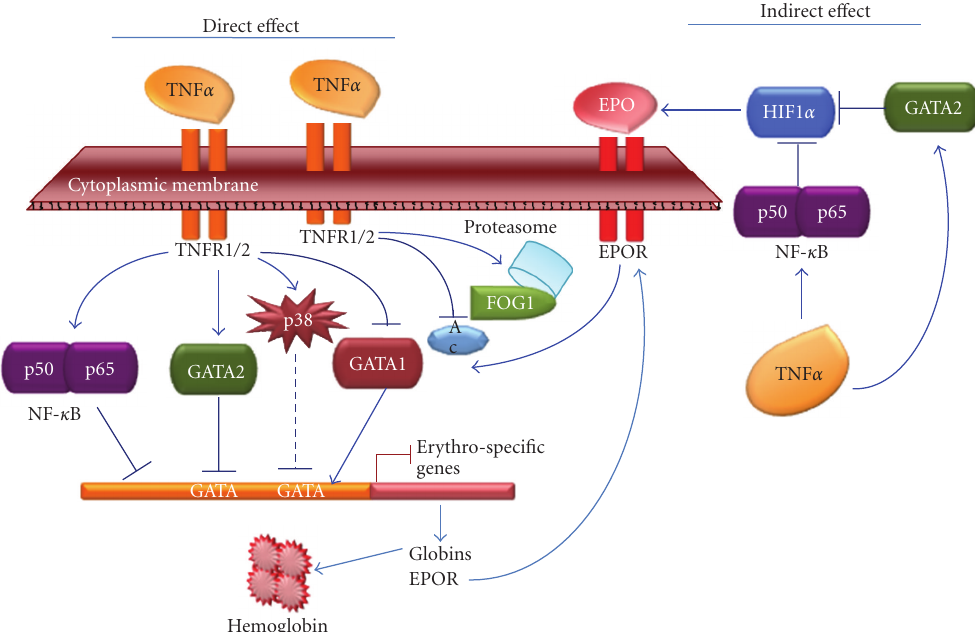
Figure 1: TNF α inhibits erythropoiesis by direct and indirect e ff ects . In the indirect e ff ect, TNF α activates the transcription factors NF- κ B and GATA-2, which were also reported as involved in Epo production inhibition by blocking HIF1 α in vitro. Low level of Epo decreases the EpoR-mediated signaling pathways resulting among others, in the down-regulation of GATA-1, and consequently in a possible deregulation of EpoR expression. The direct e ff ect of TNF α via its receptors TNFR1/2 has also been demonstrated. The activation of the NF- κ B canonical pathway (p50/p65) inhibits erythro-specific genes expression as globin genes. TNF α was also reported as activating GATA-2 whose over- expression is known to prohibit erythropoiesis in favor of megakaryopoiesis. Conversely, TNF α inhibits GATA-1 in K562, HEL and TF1 cells. GATA-1 expression is a ff ected as well as its acetylation (Ac), and its interaction with FOG1 that was suggested to be degraded by proteasome. Moreover, TNF α was shown to rapidly stimulate p38MAPK phosphorylation in correlation with γ -globin gene down-expression while Epo had a delayed e ff ect on this kinase activation. The combined e ff ects of TNF α result in the decrease in erythro-specific genes expression and hemoglobin